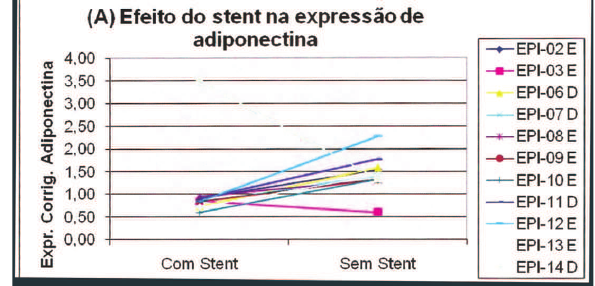
Fig. 1 - variação de adiponectina em função da presença ou